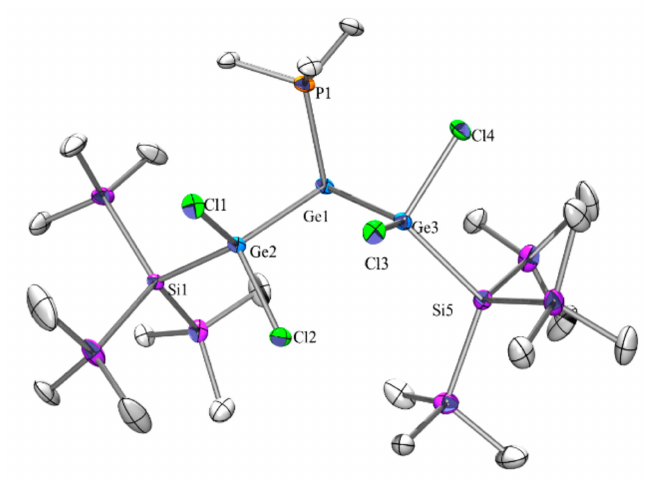
Figure 2. Molecular structure of 4 (thermal ellipsoid plot drawn at the 30% probability level; one only partially (ca. 75%) occupied pentane molecule was observed in the asymmetric unit). All hydrogen atoms omitted for clarity (bond lengths in Ả , angles in deg). Ge(1)–P(1) 2.3900(16),